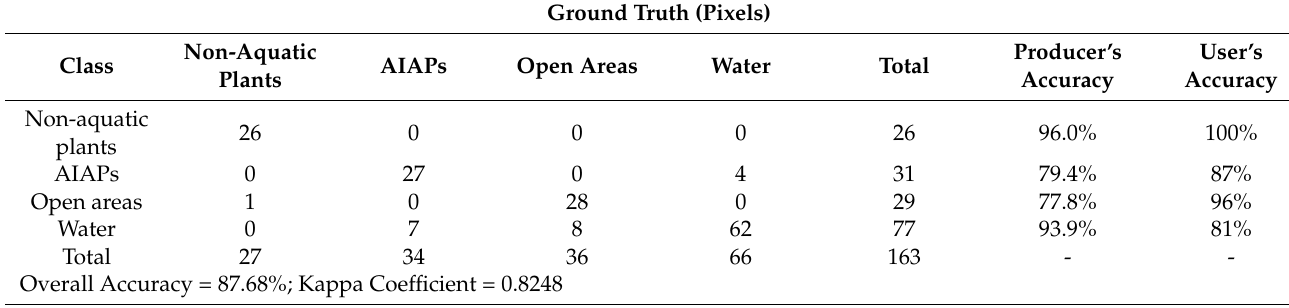
Error matrix for 2000 Landsat 7 ETM+ classified